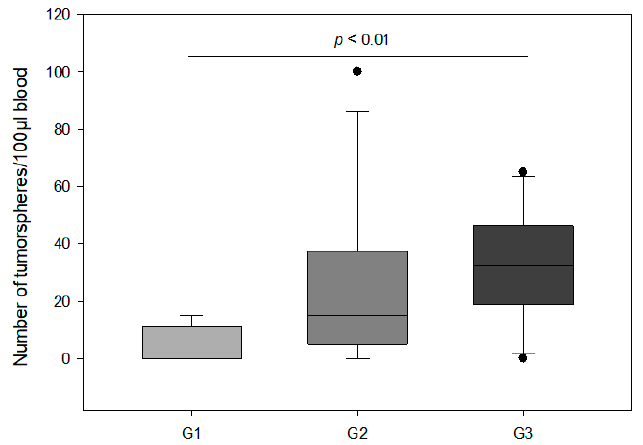
Figure 4. Box plot analysis of the number of tumorspheres according to the histologic tumor grade 1 (G1—well-differentiated tumor; G2—moderately differentiated tumor; G3—poorly differentiated tumor). The horizontal line in box-plot depicts median value. Dots specify